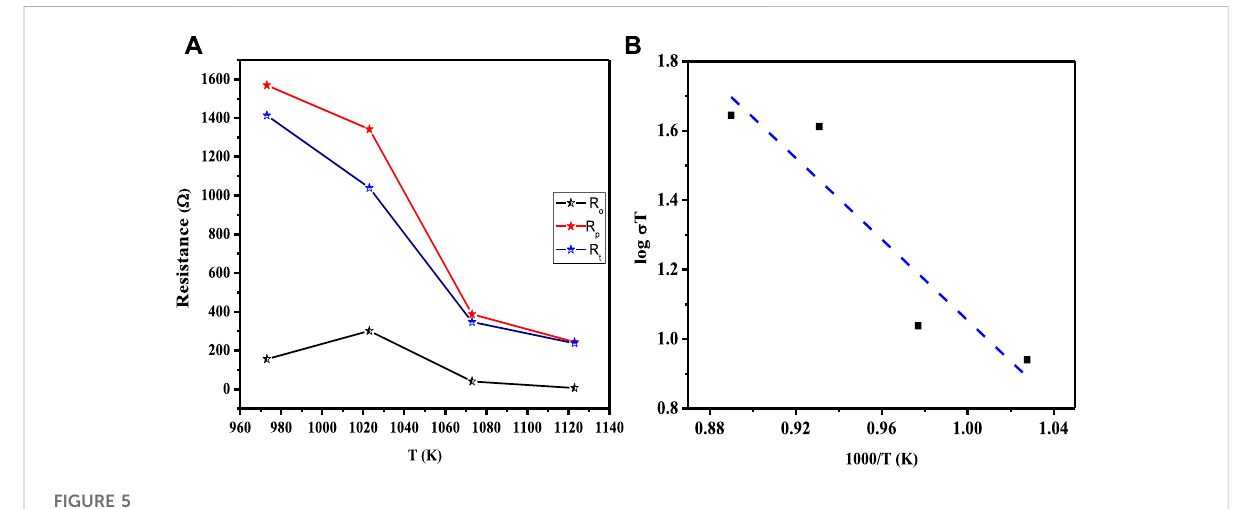
FIGURE 5 (A) Functionalplotbetweenvariousresistances(R o ,R p ,andR t )andworkingtemperaturesoftheasymmetricalcellusingLCNiO-5; (B) Arrhenius plot for the estimation of activation energy in LCNiO-5 based